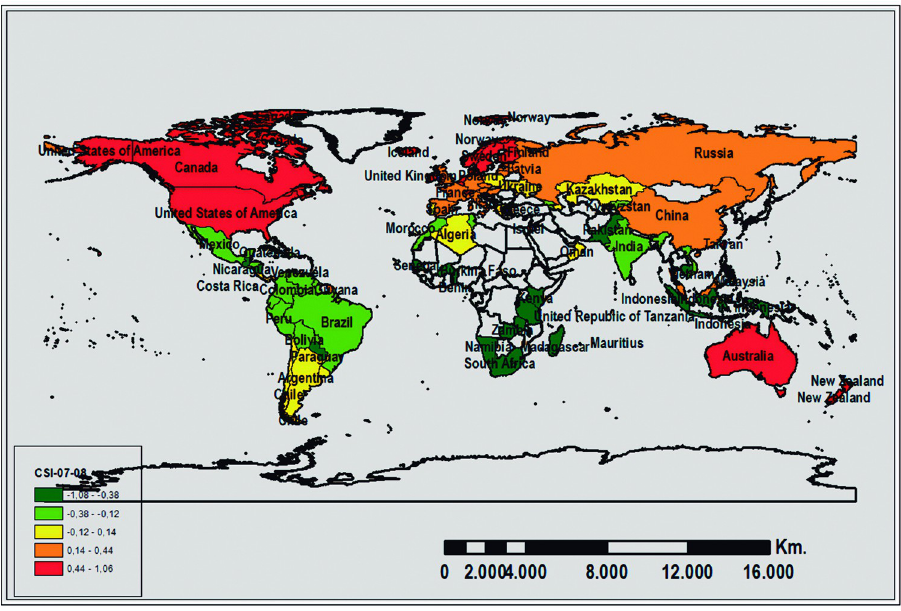
Fig 3. Geographic distribution of the CSI scores for 2007–08. Source: Prepared by authors using ArcGIS software.